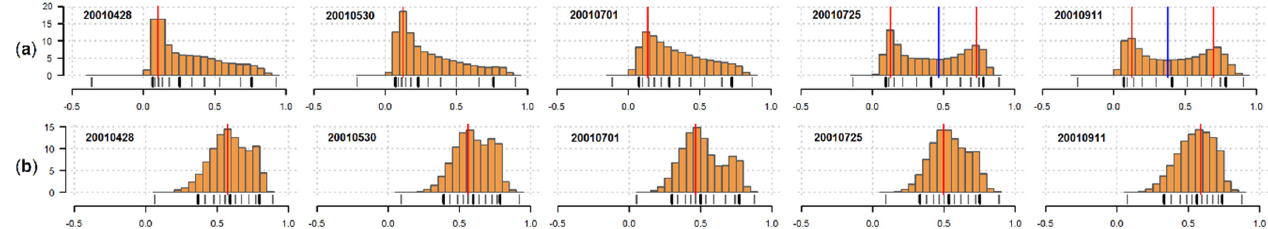
Figure 3. The temporal relative frequency distribution of the NDVI is displayed for ( a ) irrigated herbaceous crops and ( b ) broadleaf evergreen forest categories. Percentage values are shown in the vertical axis, while the NDVI range of values is presented in the horizontal axis. The red and blue vertical lines define modes (Mo) and antimodes (AMo), respectively; modelled locations are useful when multimodality is assessed [96]. Dates are in year-month-day format.